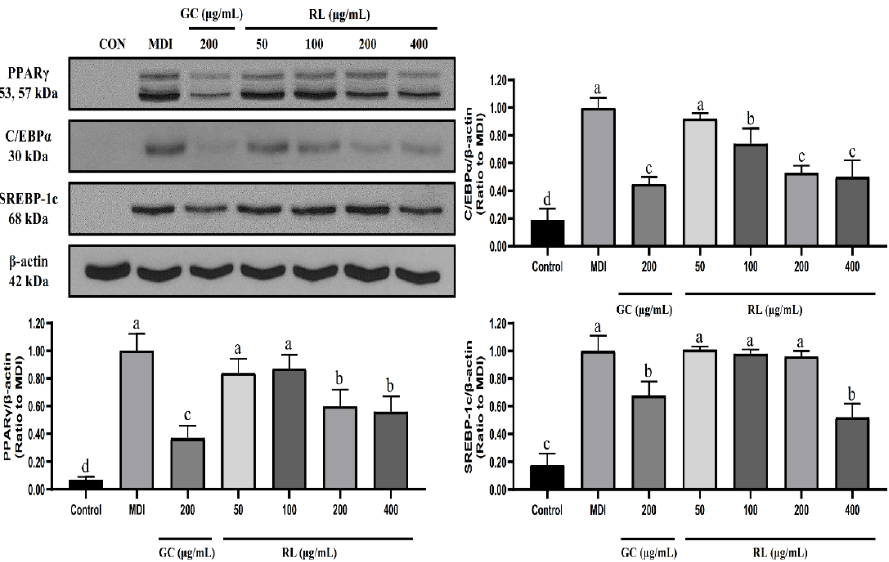
Figure 4. Effects of RL at various concentrations on the expression levels of 3T3-L1 adipocyte